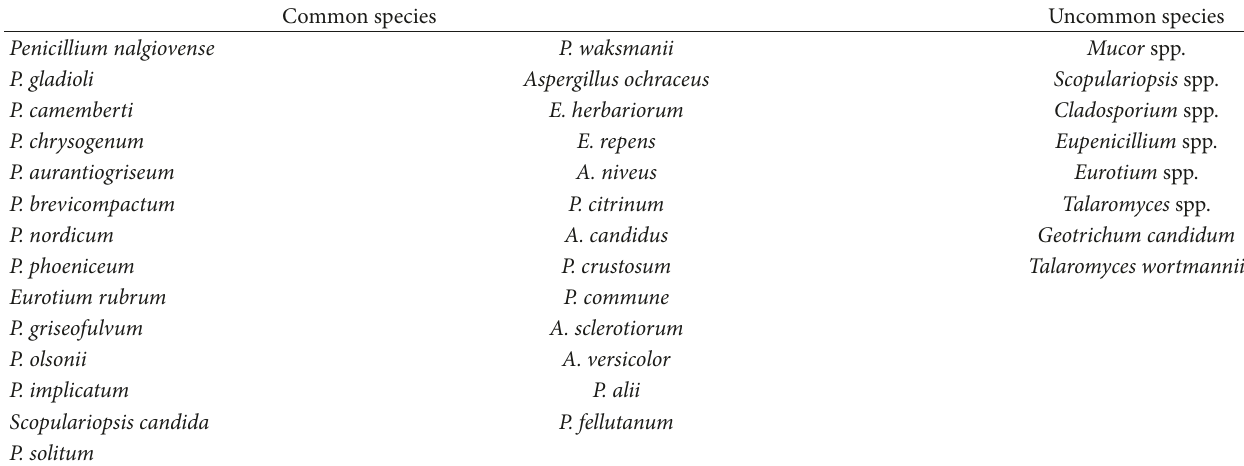
Table 3: Species of moulds usually found in dry-fermented